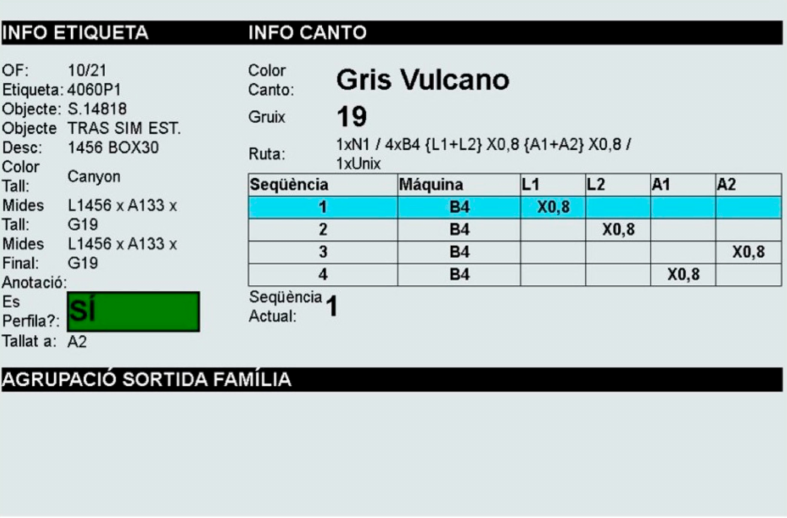
Figure 9. Asynchronous Web Dashboard to provide Work